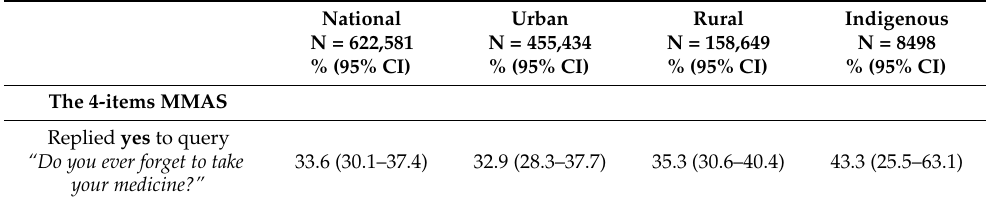
Table 2. Adherence to medication among treated hypertensive individuals using the 4-item Morisky Medication Adherence Scale from the ENSPA study, stratified by